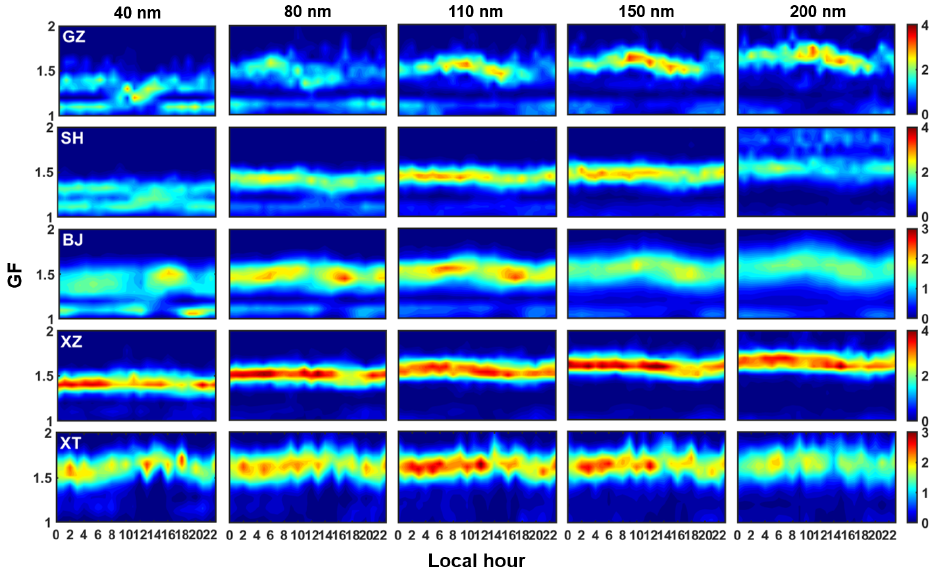
Figure 4. Campaign-averaged diurnal variations in GF-PDFs for all measured dry particle sizes (40–200nm) at different sampling sites (GZ, SH, BG, XZ, and XT sites). The color scales denote the GF-PDF.